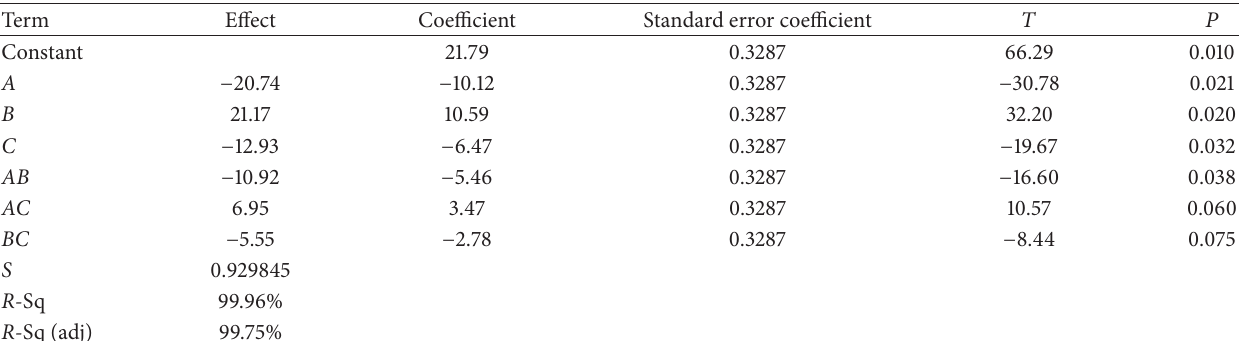
Table 6: Statistical parameters for 2 3 design.